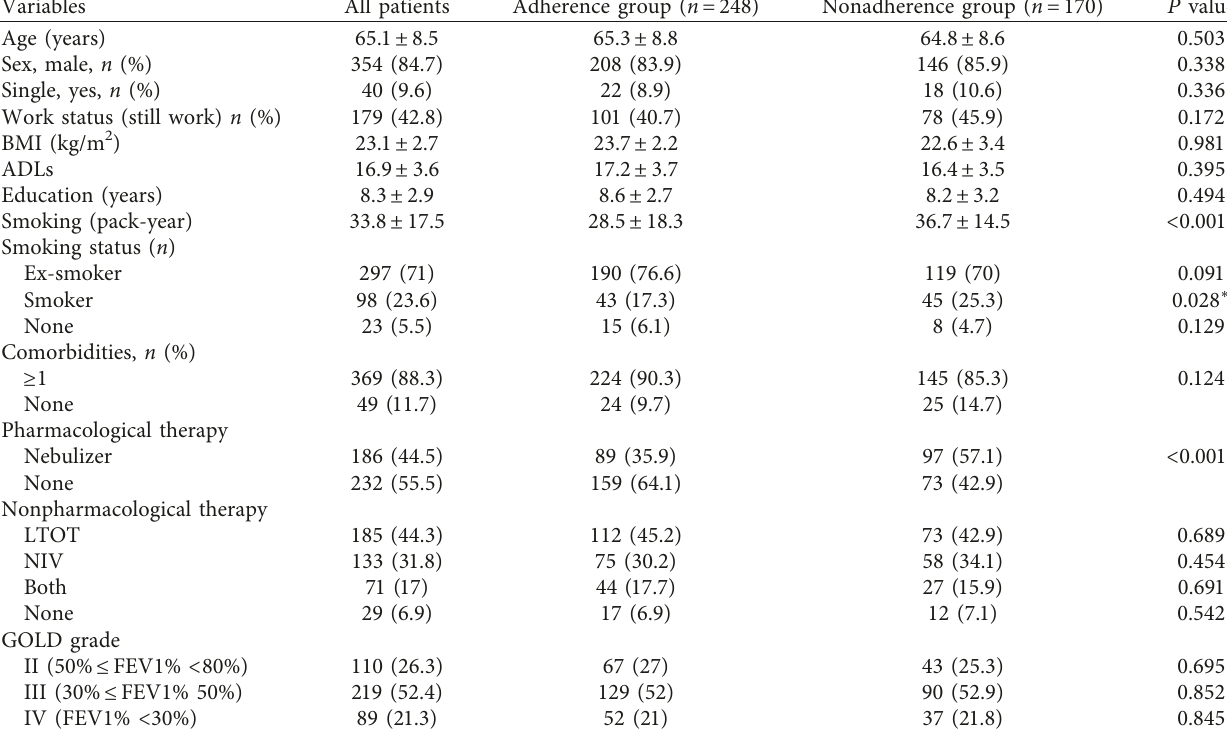
Table 1: Demographic characteristics of participants at baseline ( n �